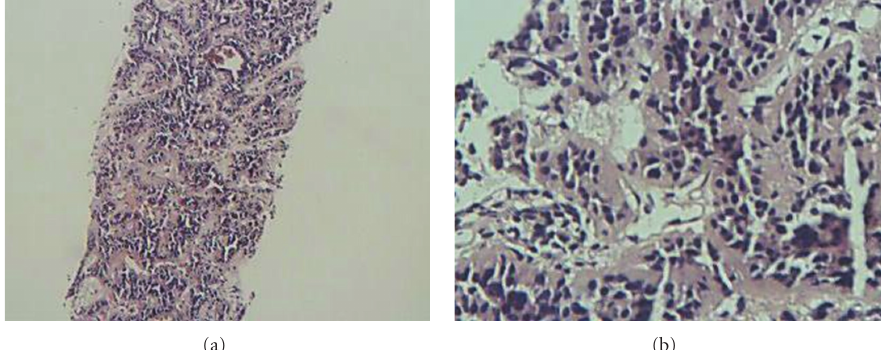
Figure 2: Monotonous cells look like gland islets with preservation of the regular cords, compatible with